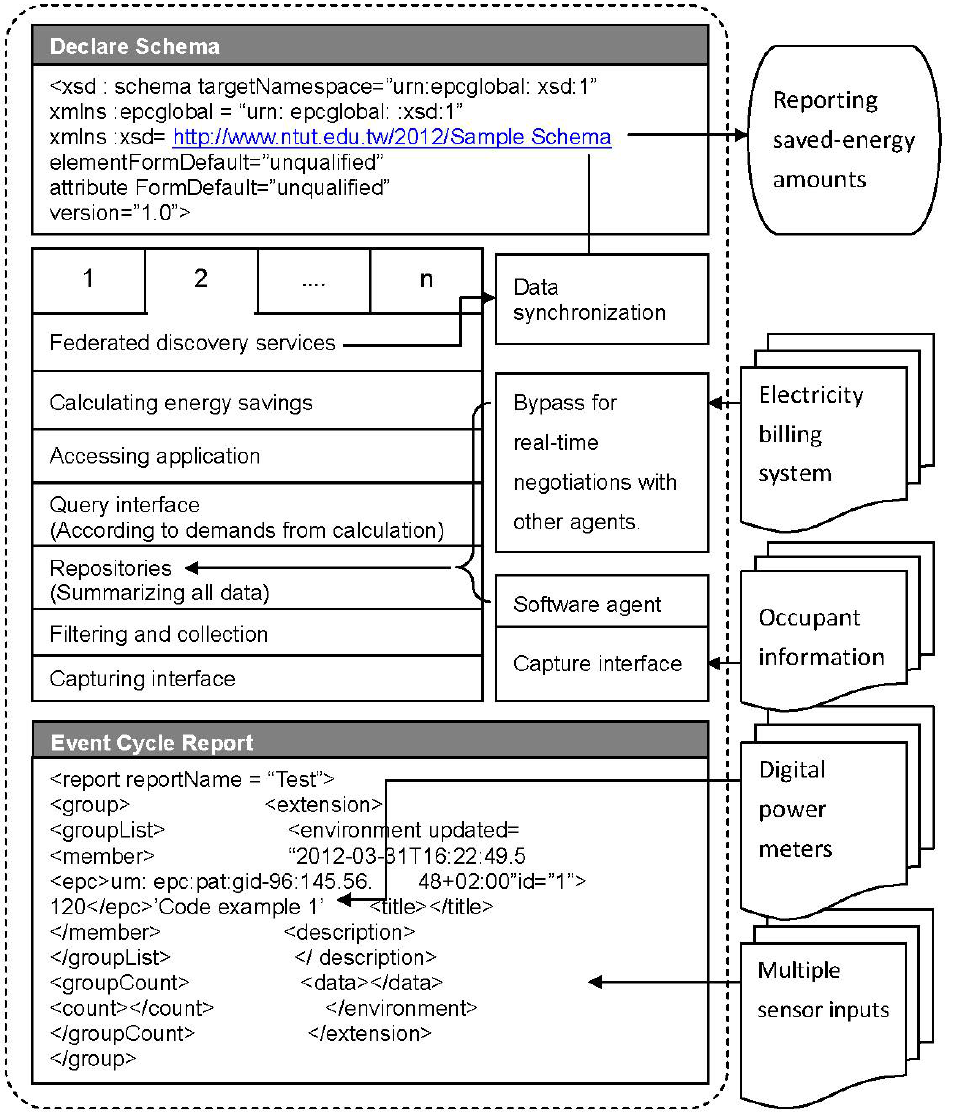
Figure 2. Architectural framework of the sensor platform for the measurement of energy